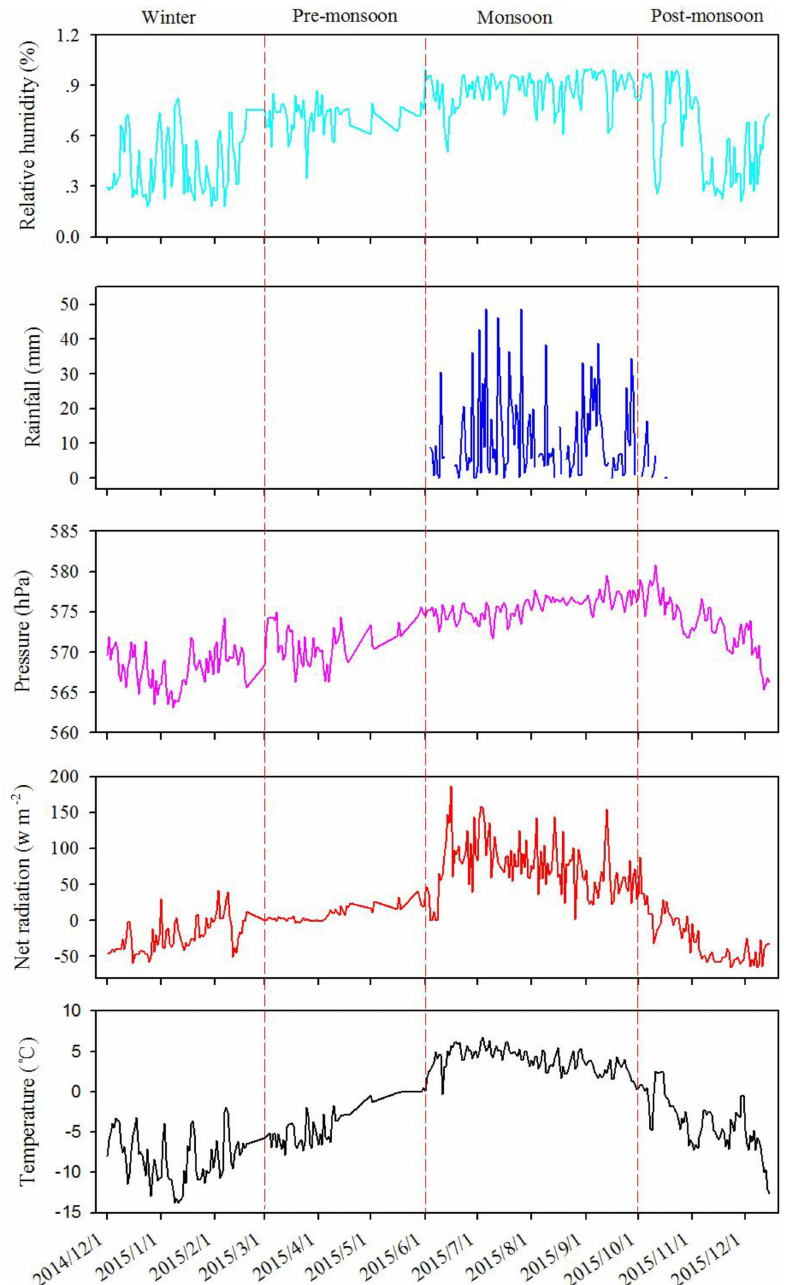
Figure 2. Time series of meteorological parameters (air temperature, net radiation, pressure, rainfall, relative humidity) at Mt. Yulong from December 2014 to December 2015. Monsoon and non-monsoon seasons (including winter, pre-monsoon, post-monsoon seasons) are divided by vertical